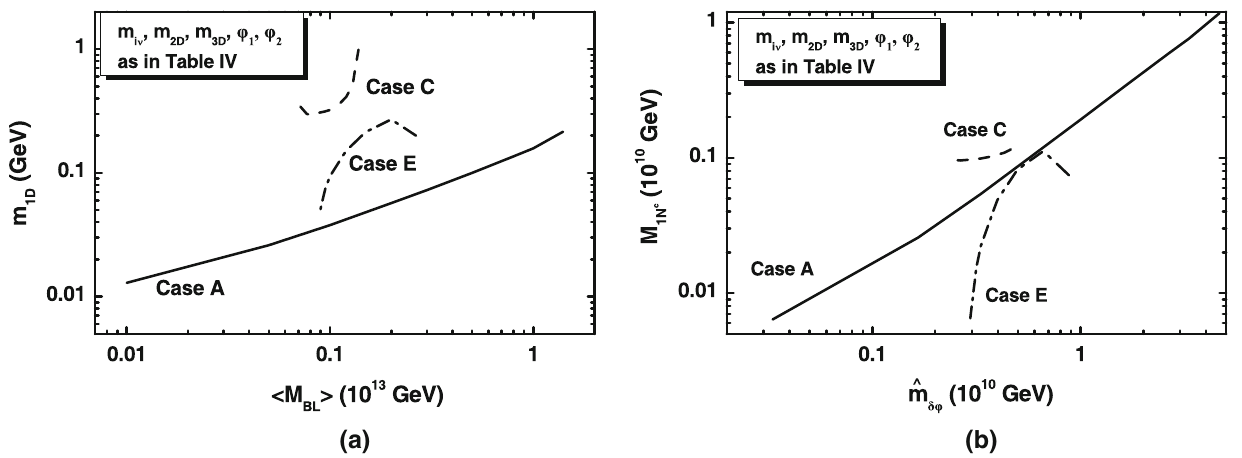
m 2D , m 3D , ϕ 1 and ϕ 2 which correspond to the cases A (solid line), C (dashed line) and E (dot-dashed line) of Table